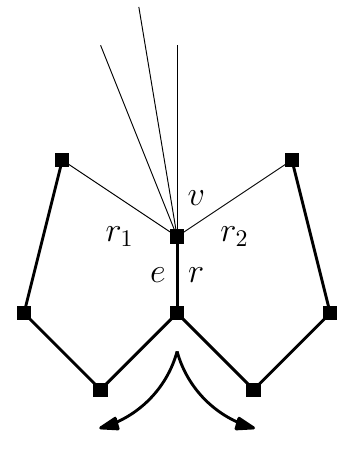
Figure 10 . Two cycles with a common